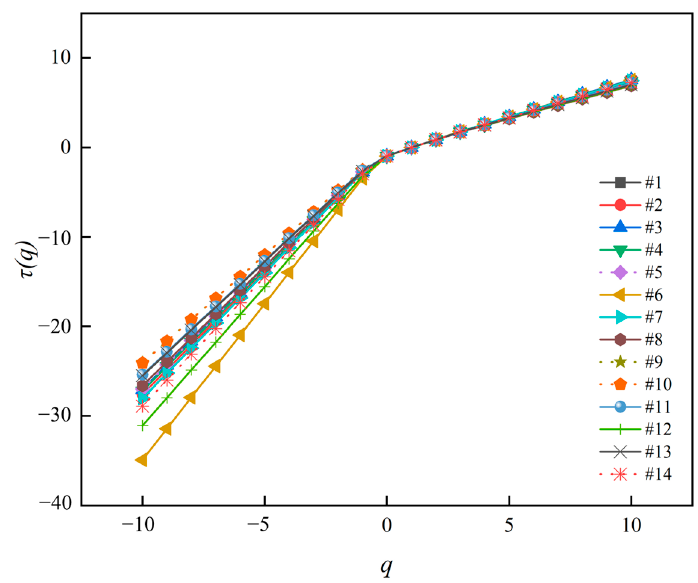
Figure 8. Relationship between τ ( q ) and q (samples of solid lines used to establish the model, samples of dotted line used to verify the model).